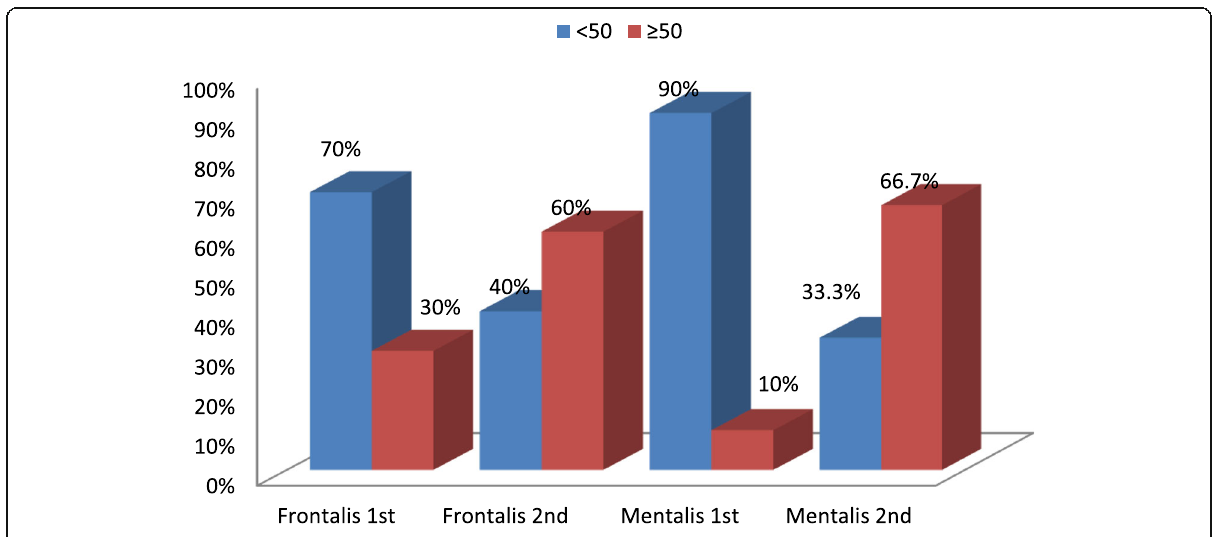
Fig. 3 Amplitude degeneration ratio of the frontalis and mentalis of the affected side